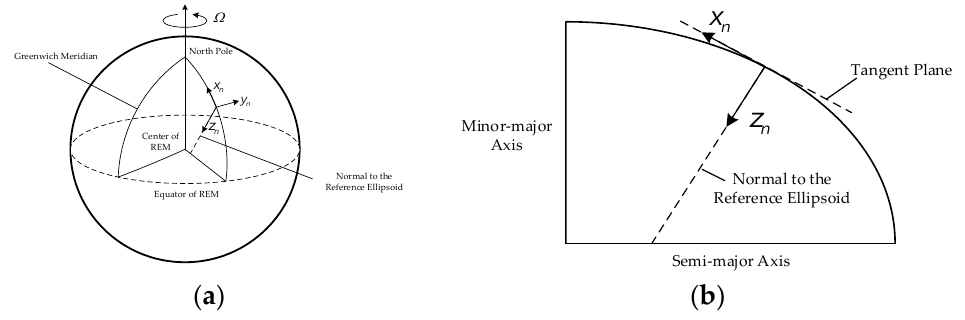
Figure 1. The definition of the navigation coordinate frame with North-East-Down definition. ( a ) is the definition of navigation coordinate frame with North-East-Down definition, ( b ) is the side view of ( a ).